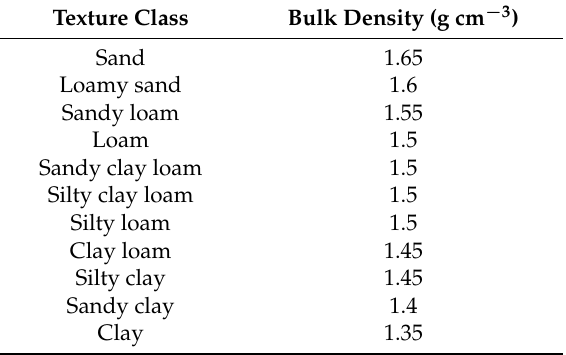
Table 1. Typical values of the bulk density for soil texture